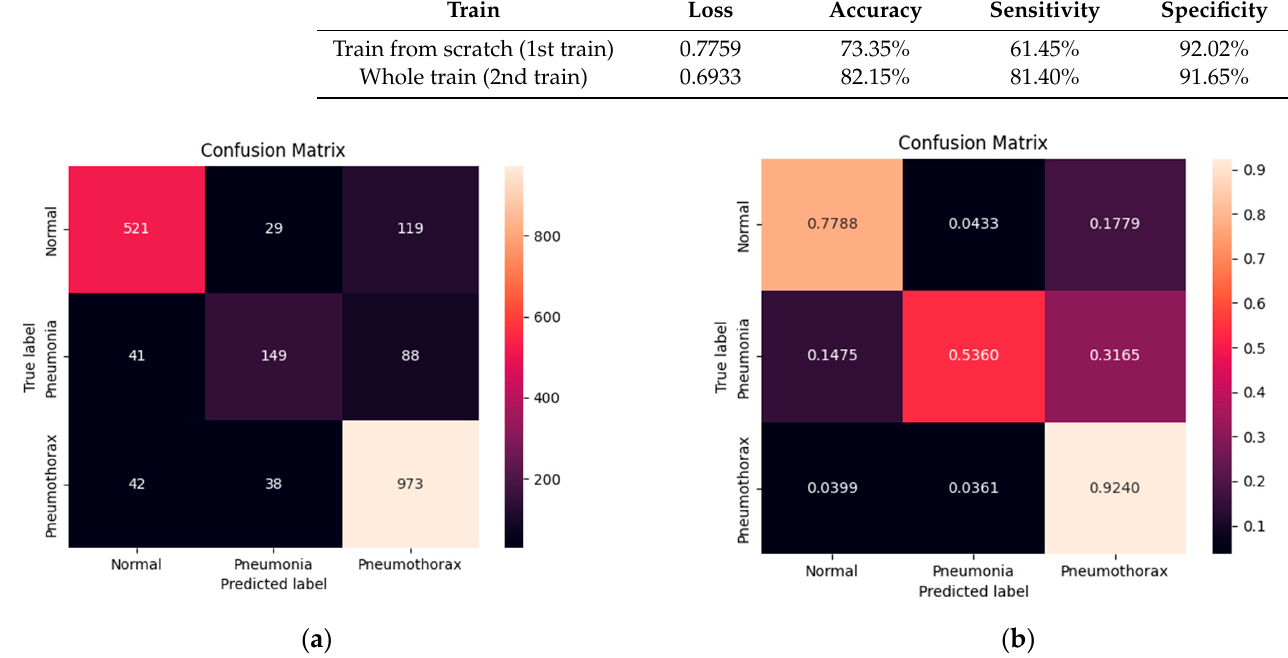
Figure 8. Confusion matrix of the pneumonia, pneumothorax, and normal classes of the validation set of the NIH data set: ( a ) numerical; ( b ) percentage.